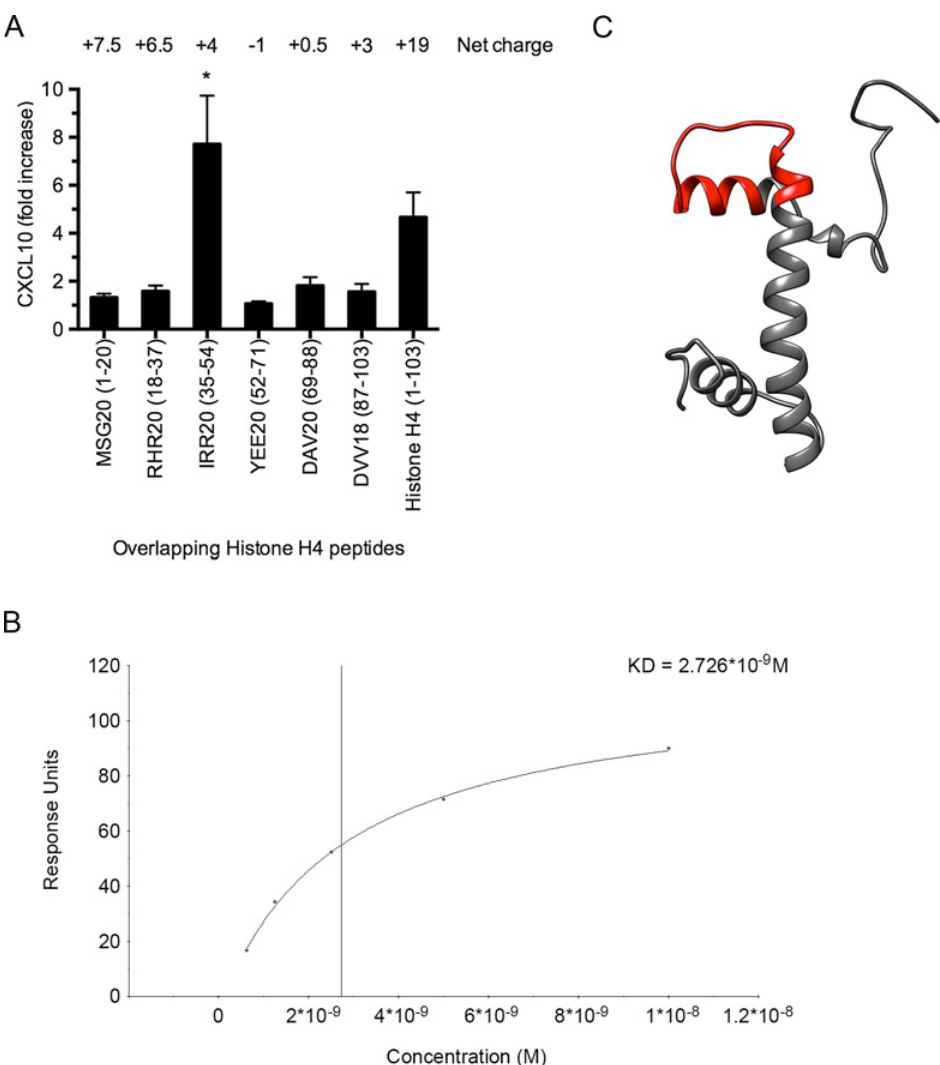
Fig 6. Histone H4 binds to TLR4/MD-2 on THP-1 cells. (A) Overlapping peptides from histone H4 (100 μ M) were incubated with heparinized blood for 12h at 37°C and CXCL10 release was measured by ELISA. (B) IRR20 was immobilized on a CM5 sensorchip and serial dilutions (200 nM – 12.5 nM) of the TLR4/MD-2 complex were applied in a flow. Steady-state affinity analysis was used to calculate the KD value (BIAevaluation software, GE Healthcare, Uppsala, Sweden). (C) The predicted structure of histone H4 was modeled using the UCSF Chimera software (http://www.cgl.ucsf.edu/chimera) with a hairpin loop corresponding to the TLR4-binding 20-mer peptide IRR20 marked in